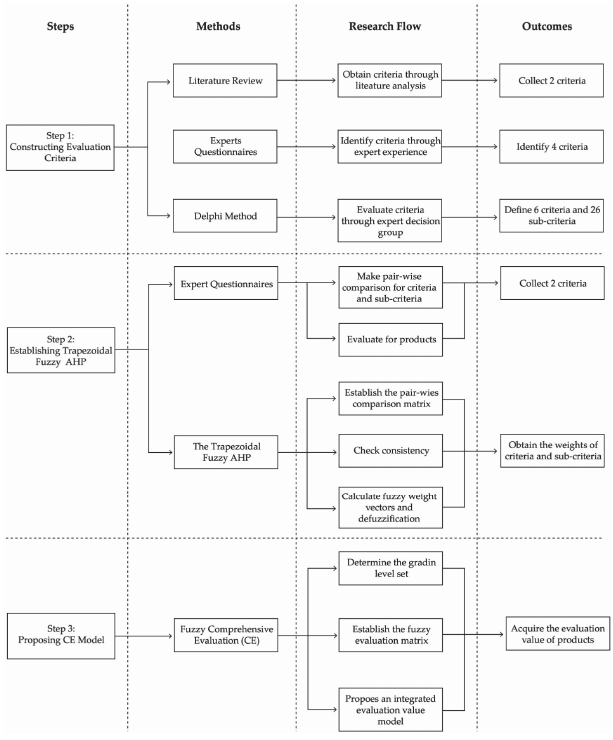
Figure 1. The analytical research framework.